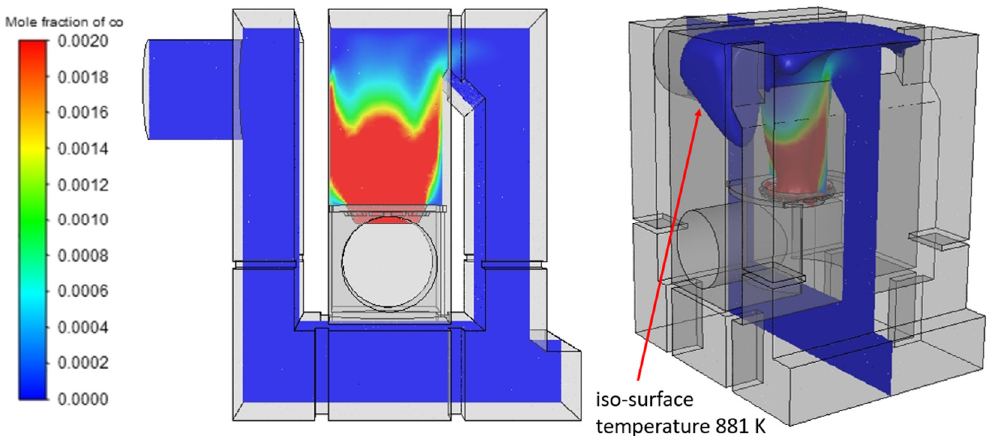
Figure 8. CO concentration (mole fraction).